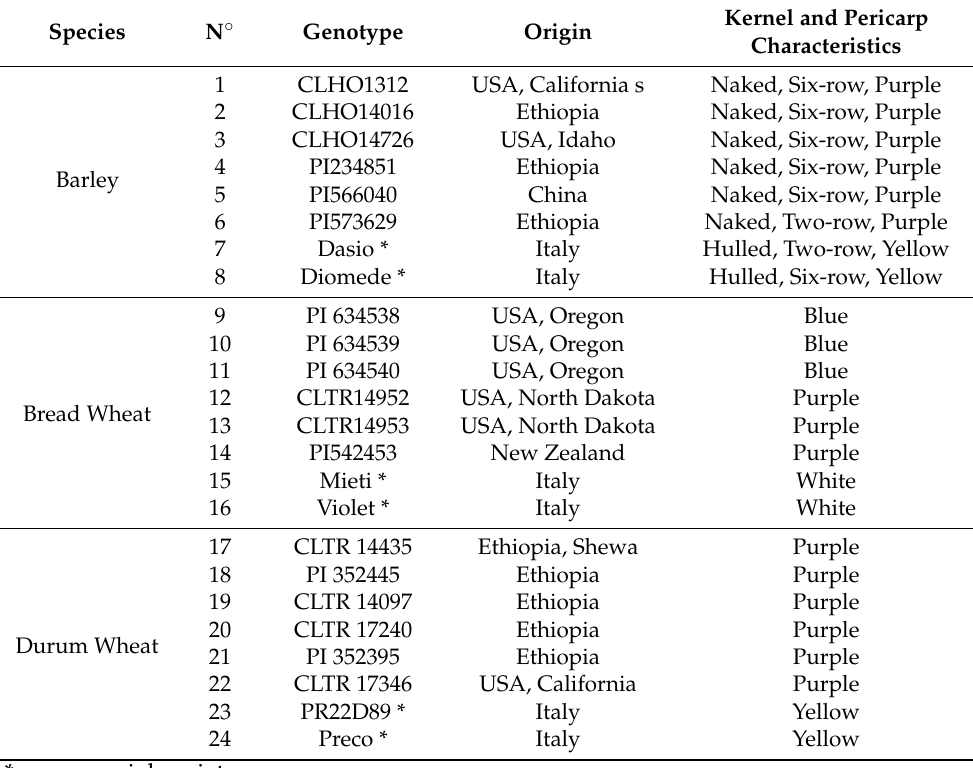
Table 1. List of genotypes of barley, bread wheat and durum wheat. Species N ◦ Genotype Origin